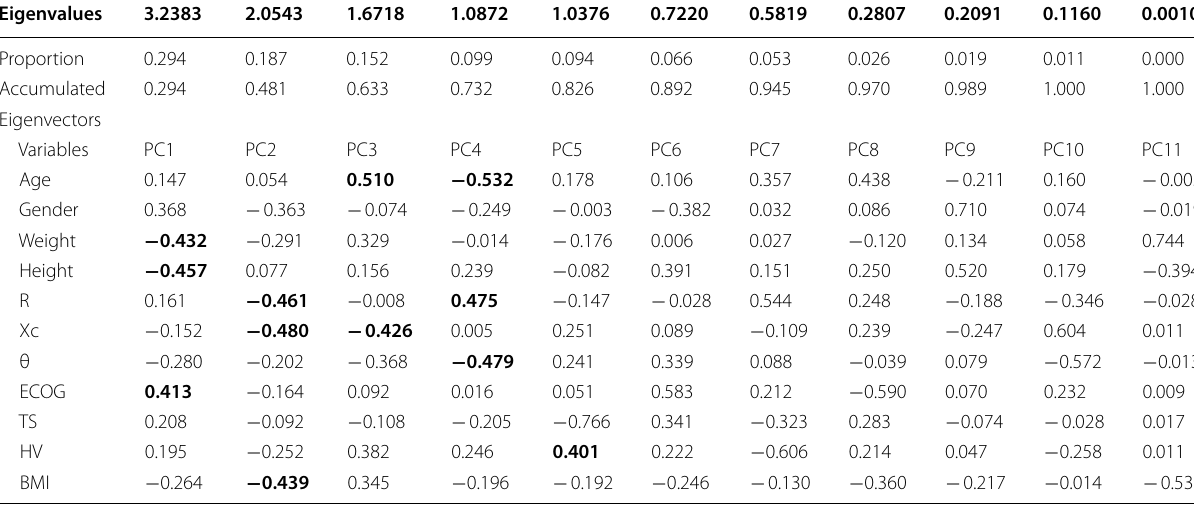
R, Xc, θ, ECOG, TS, HV, and BMI were the body electrical resistance, body electrical capacitive reactance, body phase angle, Eastern Cooperative Oncology Group, tumor stage, histological variety of the tumor, and body mass index, respectively. PC i (i